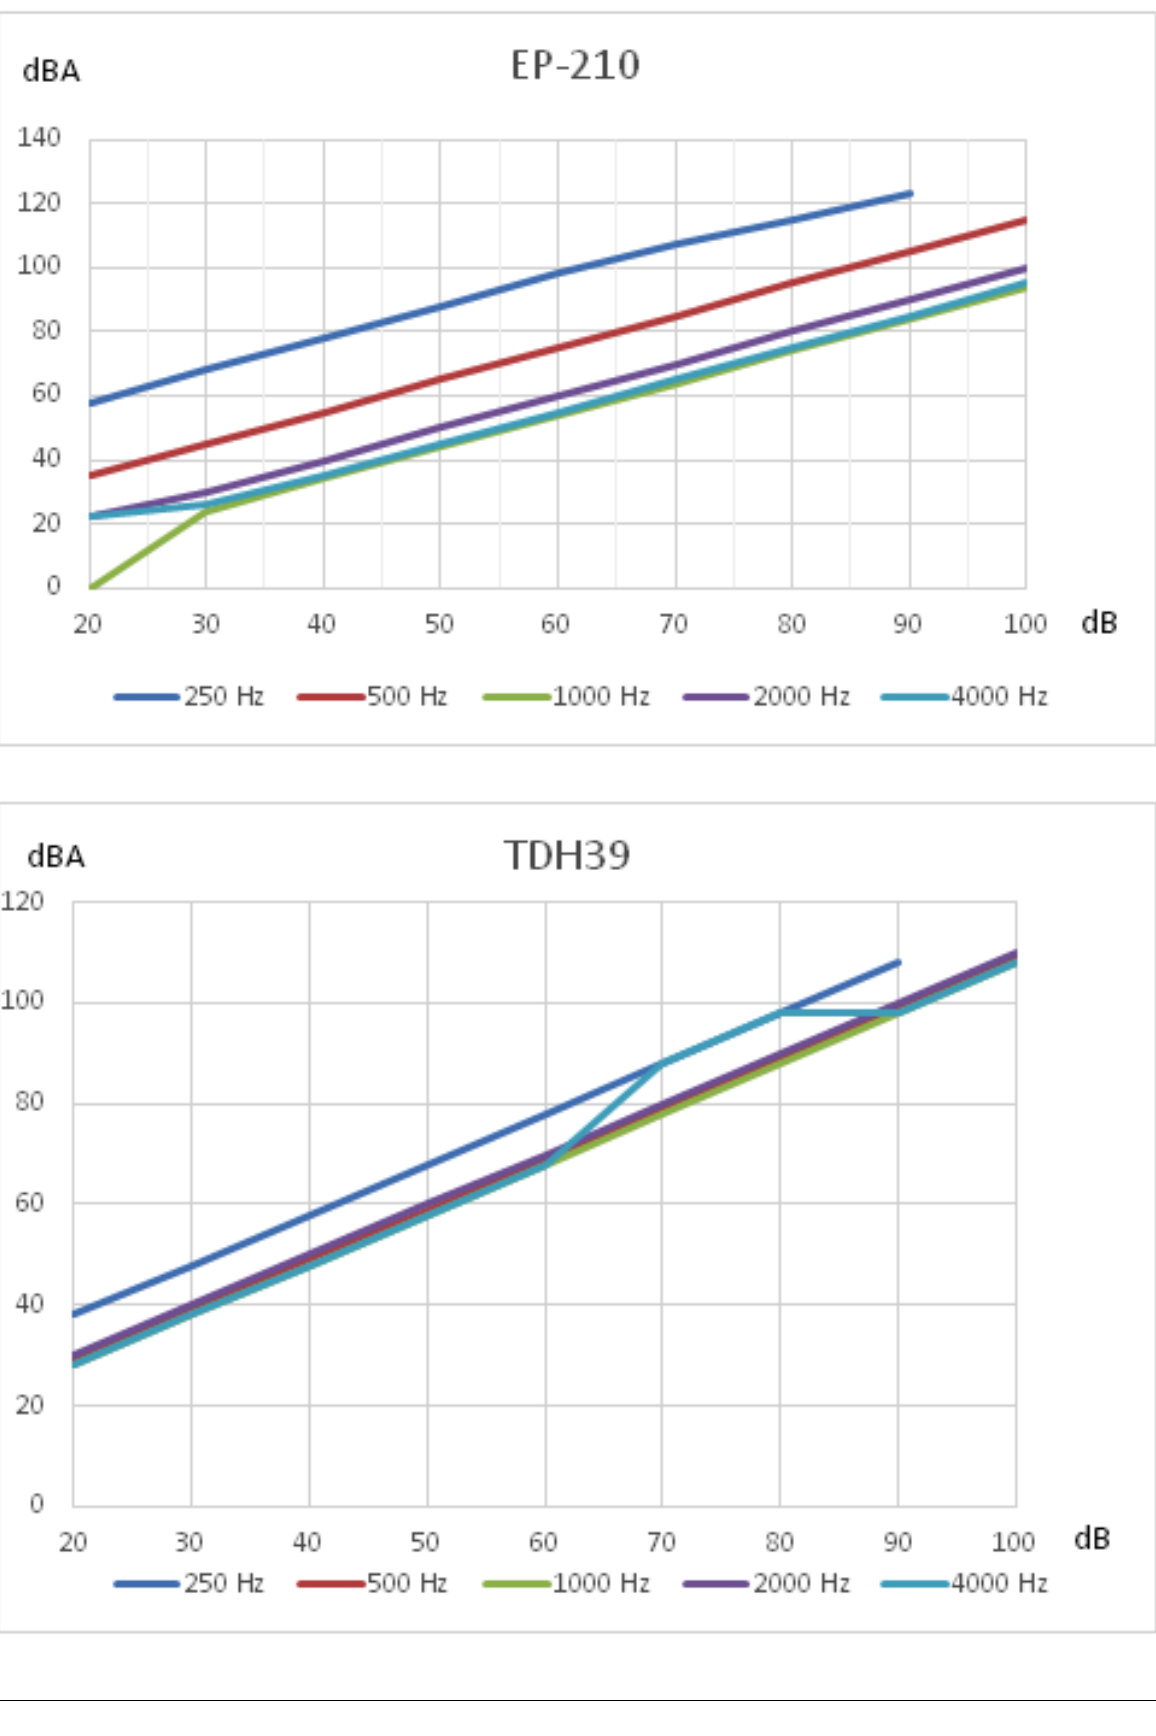
Figure 11. THD39 versus EP-210 loudness response. dBA: A-weighted